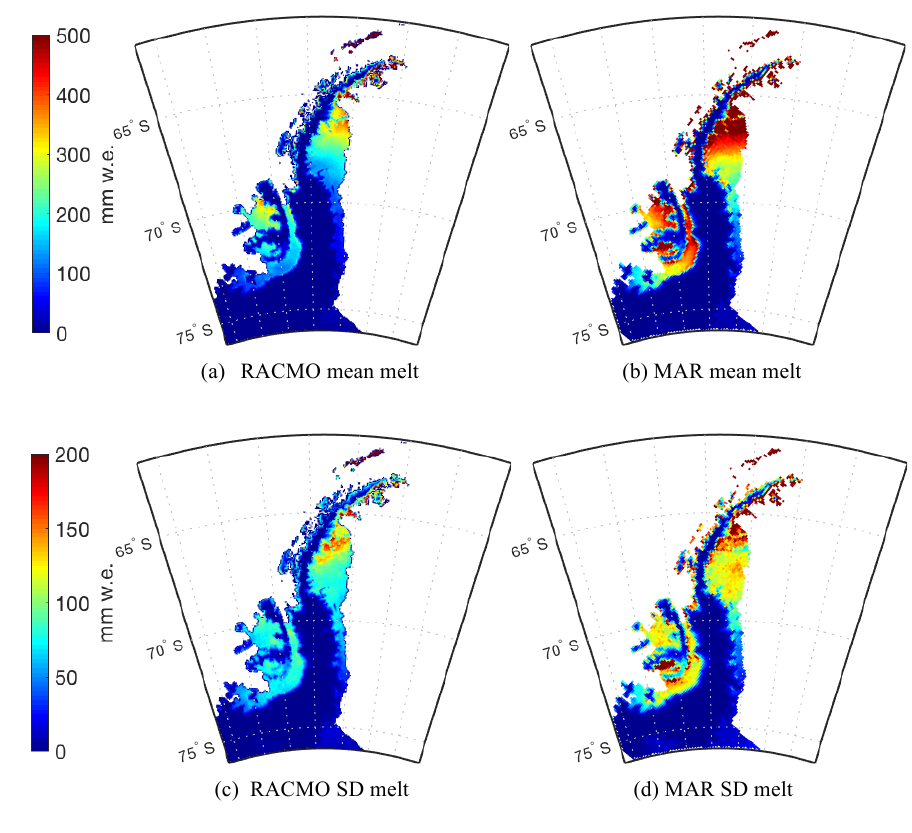
Figure 3. Meltwater production (2000–2009). RACMO2.3p2 at 5.5km resolution, mean annual meltwater production (a) , and standard deviation (c) ; and MAR v. 3.5.2 at a 10km resolution, mean annual meltwater production (b) , and standard deviation (d)